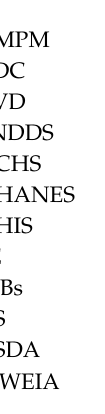
Figure S1: Flow chart defining study population and exclusions; Table S1: Trends in energy intake over time in the US by age groups; Table S2: Trends in total sugar intake over time in the US by age groups; Table S3: Percentage SSB consumers / non-consumers of total US population over time by age groups and tiers of SSB